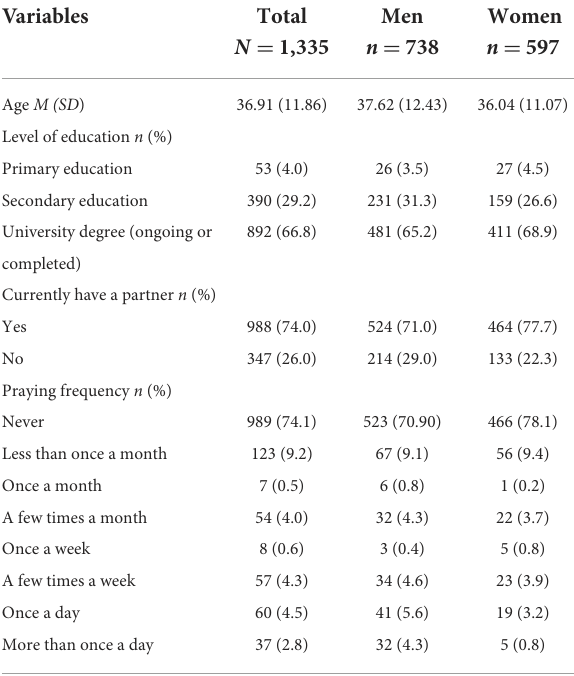
TABLE 1 Sociodemographic characteristics of the participants.